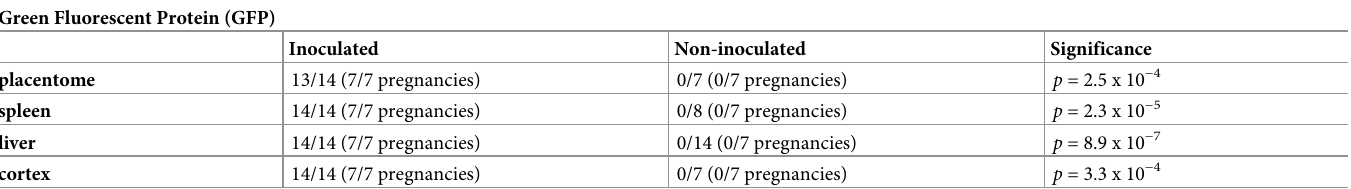
Table 3. PCR amplification of plasmid DNA encoding Green Fluorescent Protein (GFP). Data are represented as number of fetuses in which there was positive detec- tion and total number of fetuses tested for each tissue in inoculated and noninoculated pregnancies. Differences in rates of detection in inoculated versus noninoculated pregnancies were tested using Chi-Square